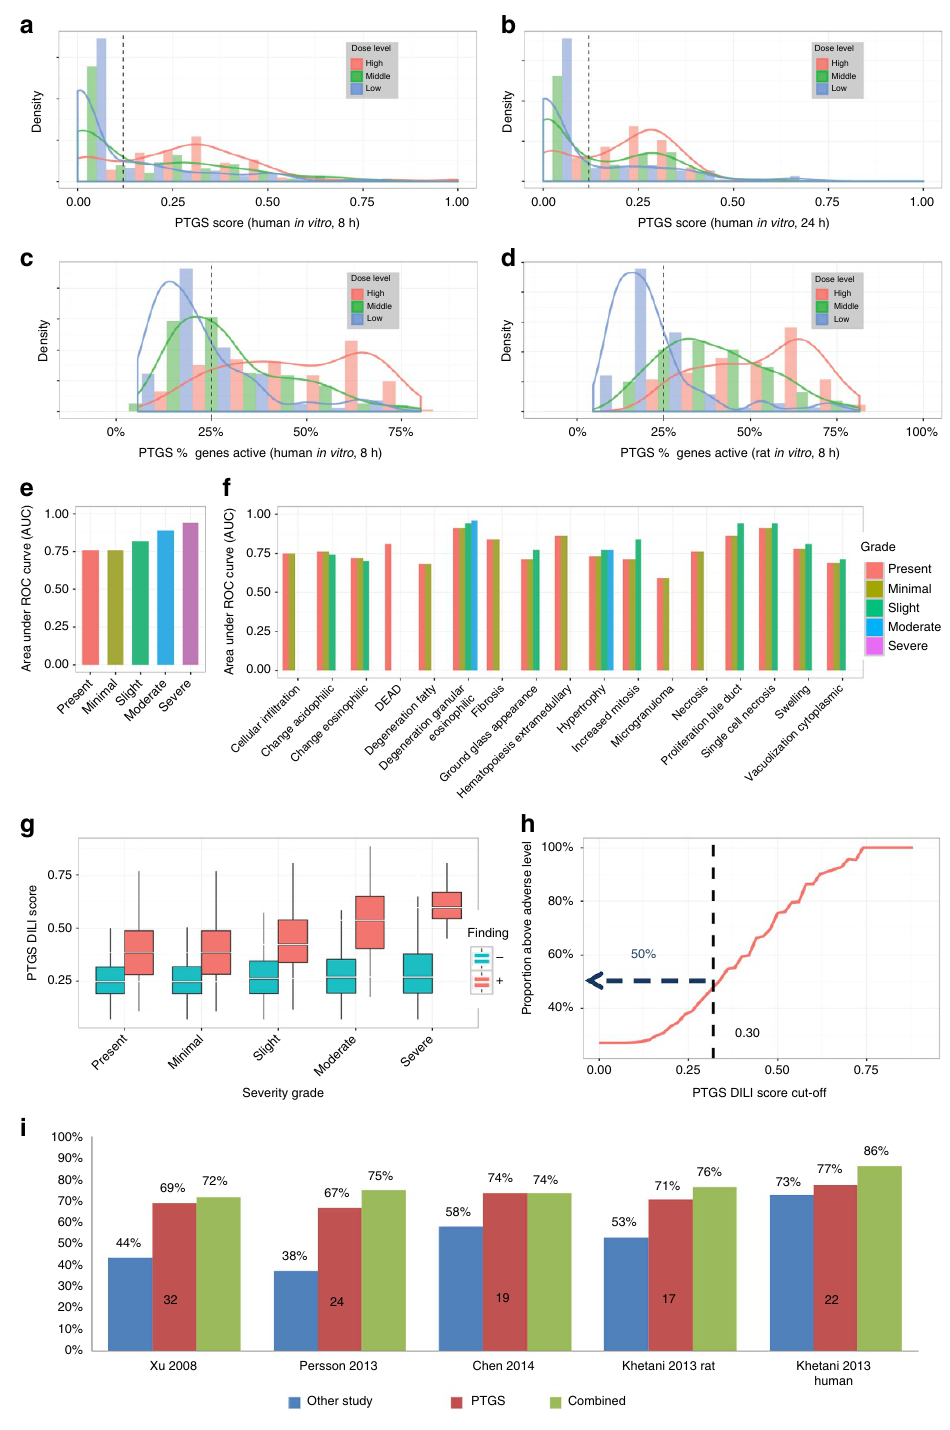
Figure 5 | Validation of the PTGS using in vitro and in vivo profiles from the TG-GATEs toxicogenomics database. The increase with dose in the proportion of treatments exceeding the virtual GI 50 -level (dashed line) in human hepatocytes measured at ( a ) 8h ( n ¼ 388) and ( b ) 24h ( n ¼ 394) and in ( c ) human ( n ¼ 388) or ( d ) rat ( n ¼ 419) hepatocytes measured at 8h, using either the component-based ( a , b ) or the gene-based ( c , d )